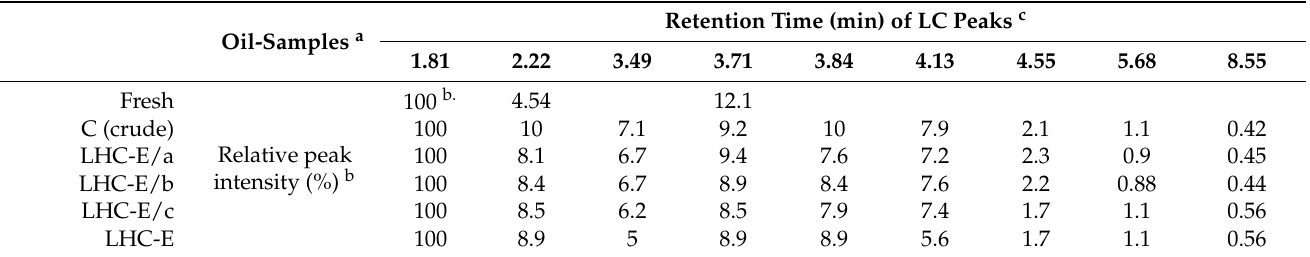
Figure 6. Electron microscopic images of the interior surfaces of SS321 tube: ( a ) crude; ( b ) by LHC; ( c ) by LHC-E; ( d ) by LHC-N. ( e , f ) The schematics show the stabilizing action of etidronic acid and 1,5-naphthalene disulfonic acid, respectively. The scale bars are 5 µ m in ( a ) to ( c ), and 10 µ m in ( d ). Table 2. The relative composition of a lubricant sample, based on LC analysis, discharged from an SS-321 tube treated by an etchant after the devised heating course.